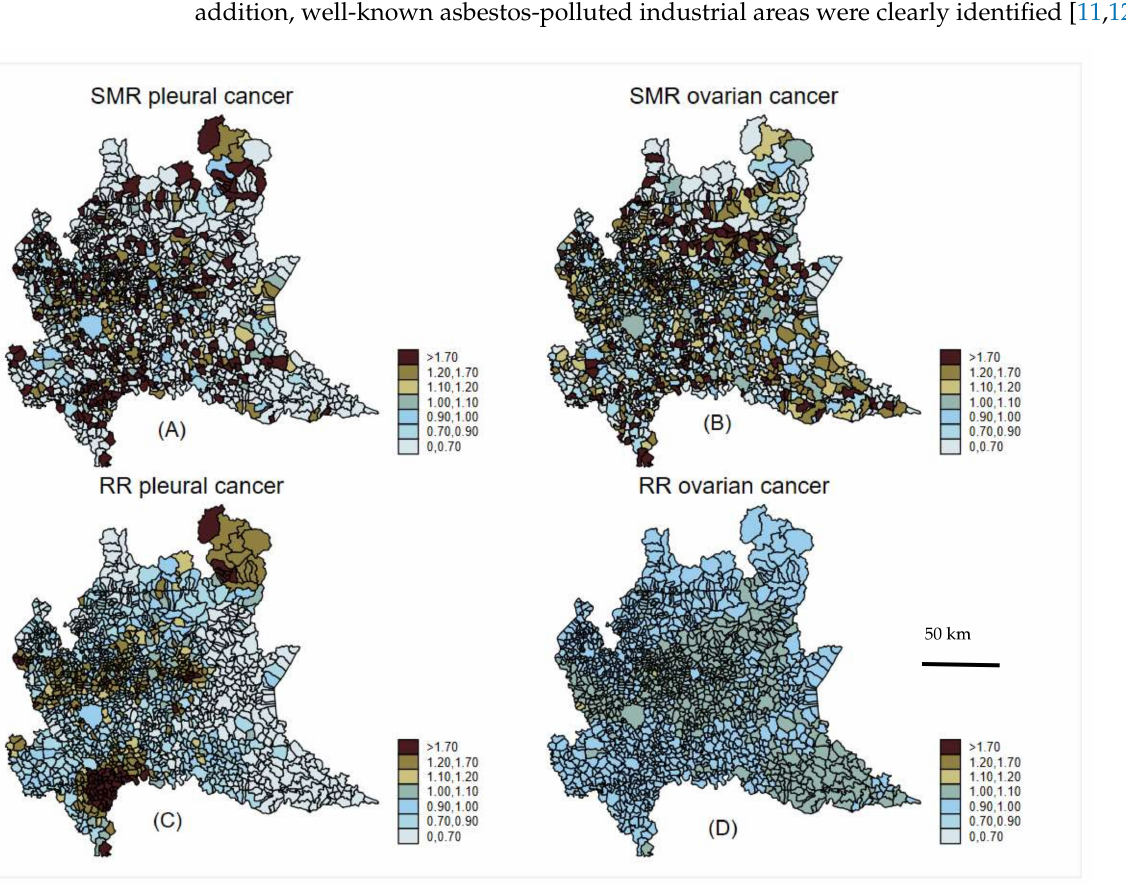
Figure 2. Spatial choropleth map of raw (SMR pleural cancer ( A ); RR ovarian cancer ( B )) and Bayesian smoothed (RR pleural cancer ( C ); RR ovarian cancer ( D )) standardized mortality ratios of pleural cancer and ovarian cancer. Lombardy Region, 2000–2018. Absolute